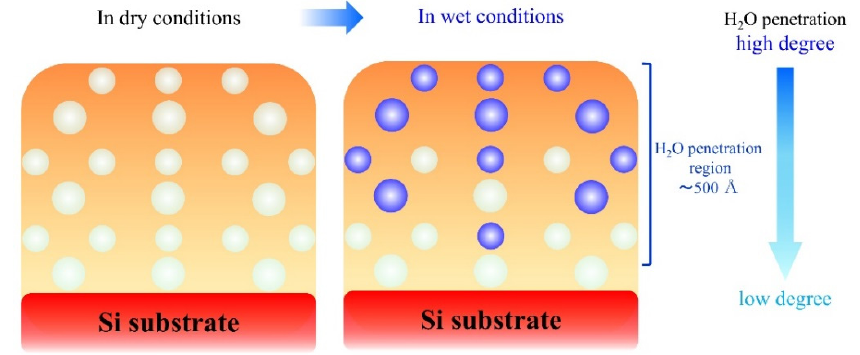
Figure 6. Illustration of the formation of water-pool structures in PDS thin layer samples in wet condition. Orange layer, white particles, and blue particles are PDS thin layer, nano-air hole, and water pool structures, respectively.